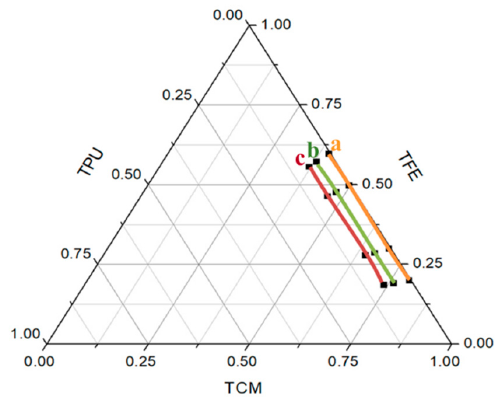
Figure 7. Mapping of the region for the production of bead free TPU fibres with: ( a ) 0.05% w / v , ( b ) 5% w / v , ( c ) 8% w / v . The area enclosed by the three colored lines indicates the ternary mixture compositions that can lead to the production of bead-free TPU nanofibers.